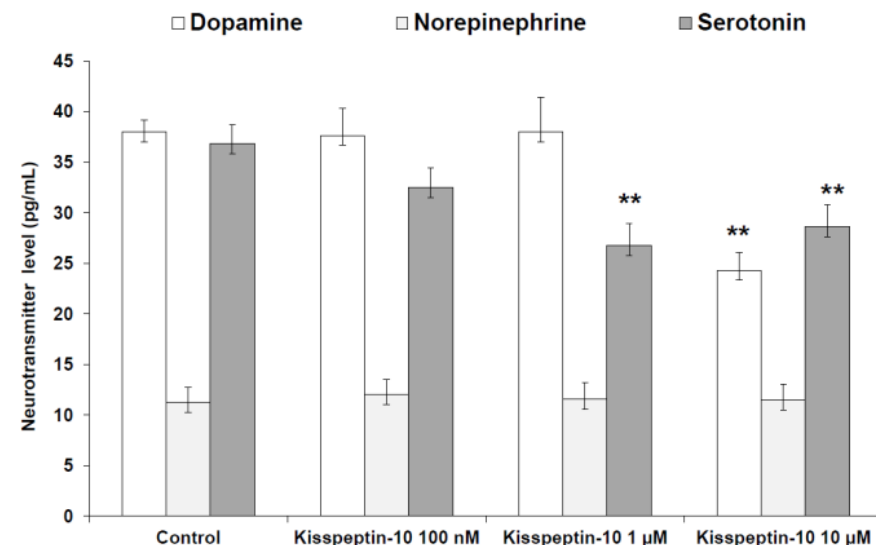
Figure 3. Effect of kisspeptin-10 (100 nM–10 μM) treatment on extracellular dopamine (DA), norepinephrine (NE), and serotonin (5-hydroxytriptamine, 5-HT) levels, as determined by HPLC in rat hypothalamic (Hypo-E22) cell line ( n = 5 individual culture flasks for each condition). Compared to control, kisspeptin-10 treatment significantly decreased extracellular DA (ANOVA, p < 0.01; post-hoc, ** p < 0.01 vs. control) and 5-HT (ANOVA, p < 0.01; post-hoc, ** p < 0.01 vs. control) levels.